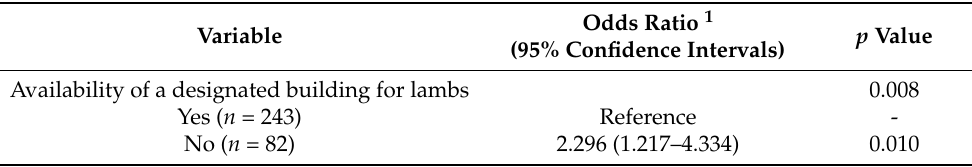
Table 4. Results of multivariable analysis for the presence of Eimeria in faecal samples from 325 sheep flocks in